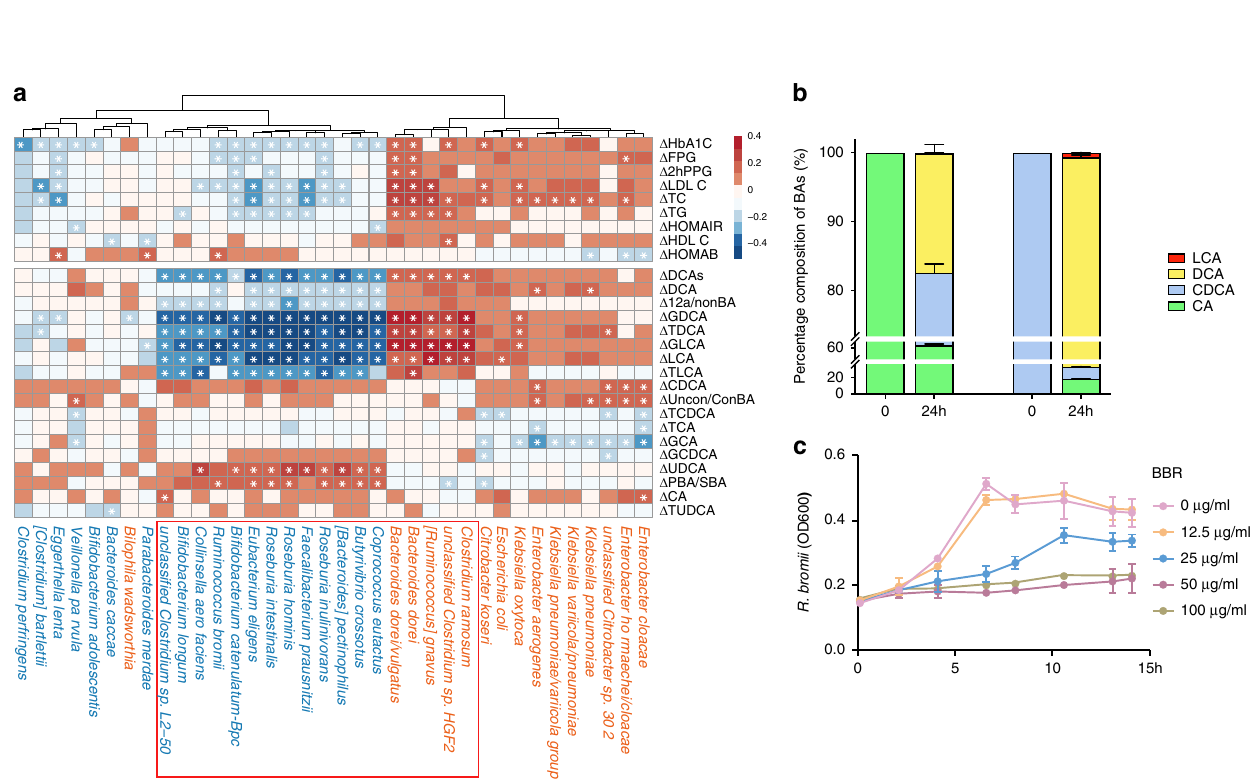
Fig. 3 BBR altered microbial BA metabolism and correlated with blood BAs and clinical outcomes. a Changes in RAs of bile acid-inducible (Bai) genes induced by the treatments of four arms. hsdh, hydroxysteroid dehydrogenase; Bsh , gene encoding bile salt hydrolase. The Z -score was calculated with the two-sided Wilcoxon matched-pairs signed-rank test. A Z -score> 0 indicated an increase after treatment, while a z -score < 0 indicated a decrease after treatment. * P < 0.01, ** P < 0.001, *** P < 0.0001; Plac, Placebo, n = 96; Prob, probiotics treatment, n = 98; BBR, berberine treatment, n = 85; Prob + BBR, berberine plus probiotics treatment, n = 102. b Comparisons of bile acid (BA) composition between baseline and post treatment in the four arms. CA, cholic acid; CDCA, chenodeoxycholic acid; DCA, deoxycholic acid; GCA, glycocholic acid; GCDCA, glycochenodeoxycholic acid; GDCA, glycodeoxycholic acid; GLCA, glycolithocholic acid; GUDCA, glycoursodeoxycholic acid; LCA, lithocholic acid; TCA, taurocholic acid; TCDCA, taurocholic chenodeoxycholic acid; TDCA, taurodeoxycholic acid; TLCA, taurolithocholic acid; TUDCA, tauroursodeoxycholic acid; UDCA, ursodeoxycholic acid. * q < 0.01, ** q < 0.001, *** q < 0.0001, two-sided Wilcoxon match-pairs signed-rank test. c Correlations between microbial BA genes and blood BA compositions at the baseline (upper panel) vs. post treatment (lower panel) for all participants, Spearman correlation, colour key represented rho value, * q < 0.01. d Heatmap of correlations between the blood BAs and clinical outcomes. Multivariate GEE controlling for age, sex and BMI. The colour key represents the β -value, * q < 0.01. e Plasma FGF19 levels pre and post treatment, * P < 0.05, ** P < 0.01, *** P < 0.001, two-sided Wilcoxon matched-pairs signed-rank test, dark lines in the boxes indicate medians, the width of the notches is the IQR, the lowest and highest values within 1.5 times the IQR from the fi rst and third quartiles, Plac, n = 96; Prob, n = 98; BBR, n = 85; Prob + BBR: n = 102. 12a/nonBA, 12a-hydroxylated/non – 12a-hydroxylated bile acids; 2hPPG, post-load plasma glucose; cp120, post-load serum C peptide; FPG, fasting plasma glucose; HbA1c, glycated haemoglobin; HOMA-IR, homoeostasis model assessment index for assessing insulin resistance; HOMA- β , homoeostasis model assessment index for assessing β -cell function; ins120, post-load serum insulin; TC, total cholesterol; Uncon/Con BA, unconjugated/conjugated bile acids. Baseline, baseline levels; post, post-treatment levels. Source data and exact P -value are provided in the Source Data fi le.